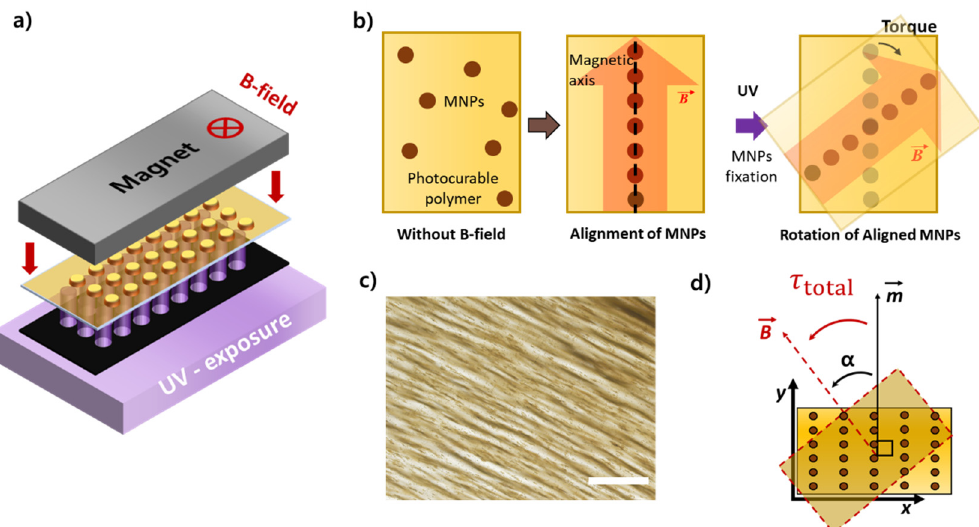
Figure 2. ( a ) Fabrication using conventional lithography setup. UV light is exposed to the dynamic photomask and then reflected to the substrate with photocurable polymers on an automated stage. ( b ) Self-assembly of magnetic nanoparticles inside polymer resin along the uniform magnetic field line. ( c ) Brightfield micrograph of the 1D magnetic chain structure located in the cross-section of the microparticle. Scale bar, 100 µm. ( d ) A schematic of torque induction and the particle spinning based on 1D magnetic nanoparticle chain structures.